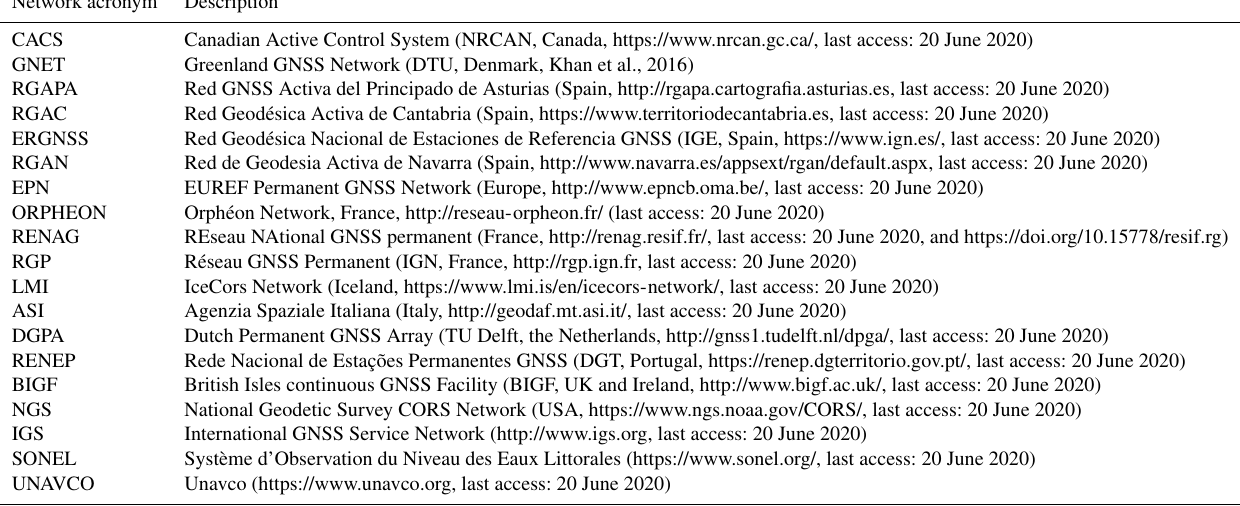
Table A1. Lists of data providers used in this study.